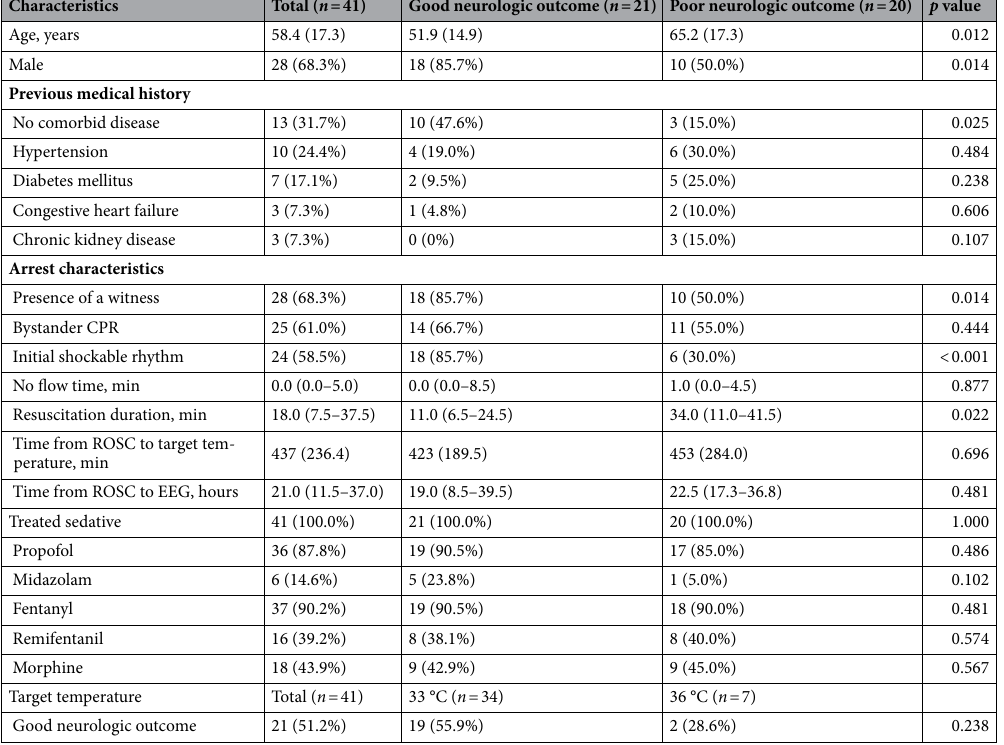
Table 1. Comparison of the clinical characteristics between the out-of-hospital cardiac arrest patients with good and poor neurologic outcomes at 1 month. Values are expressed as median (interquartile ranges) or n (%) as appropriate. CPR cardiopulmonary resuscitation, ROSC return of spontaneous circulation, EEG